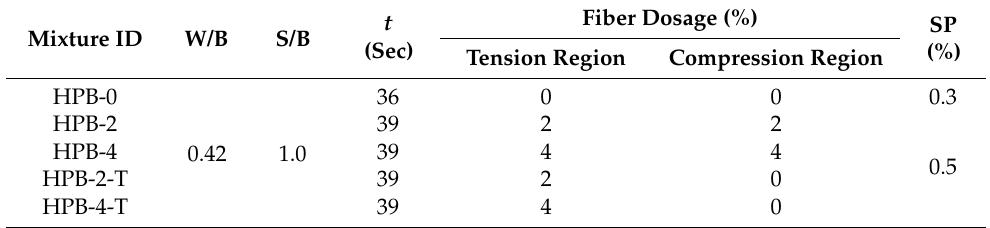
Figure 7. Compression and Tension zone in TOHPB. Table 3. Mix composition.